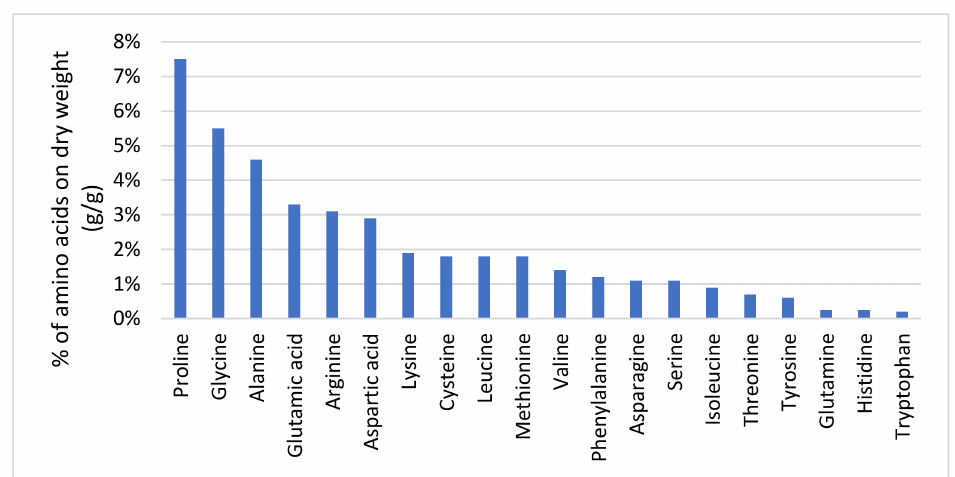
Figure 2. The amino acids profile of the PHA enriched biomass obtained in Period 3.